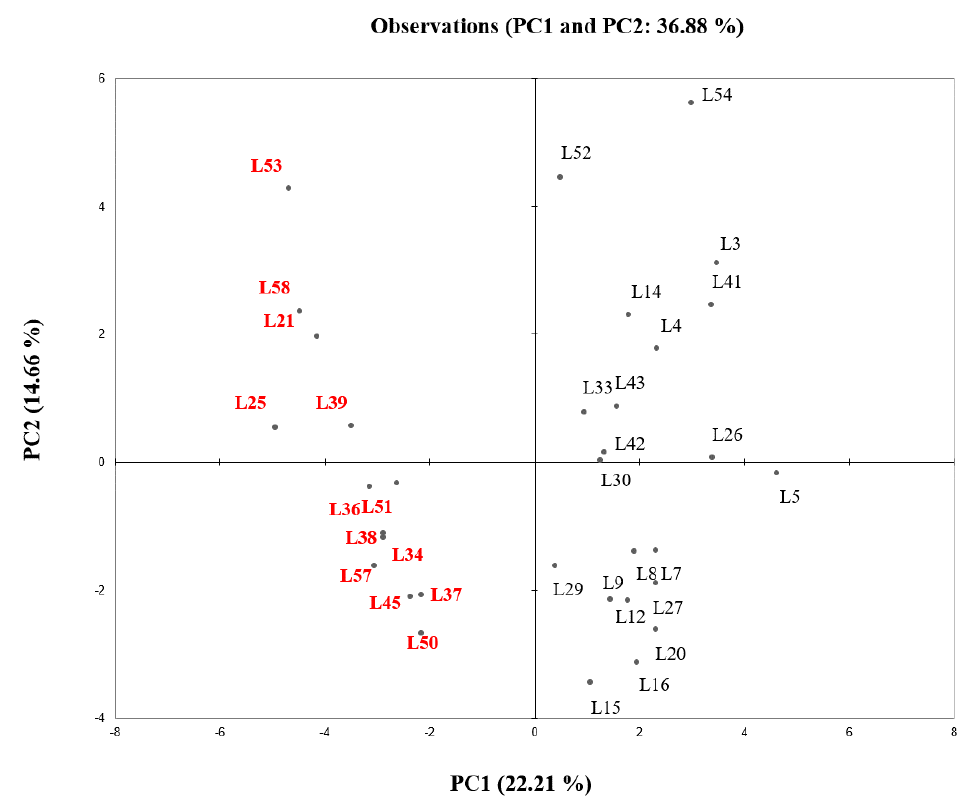
Figure 3. Score plots obtained from the PCA of essential oil compositions of Trentino Alto Adige and Lombardy wild accessions. Trentino Alto Adige accessions are indicated in red.